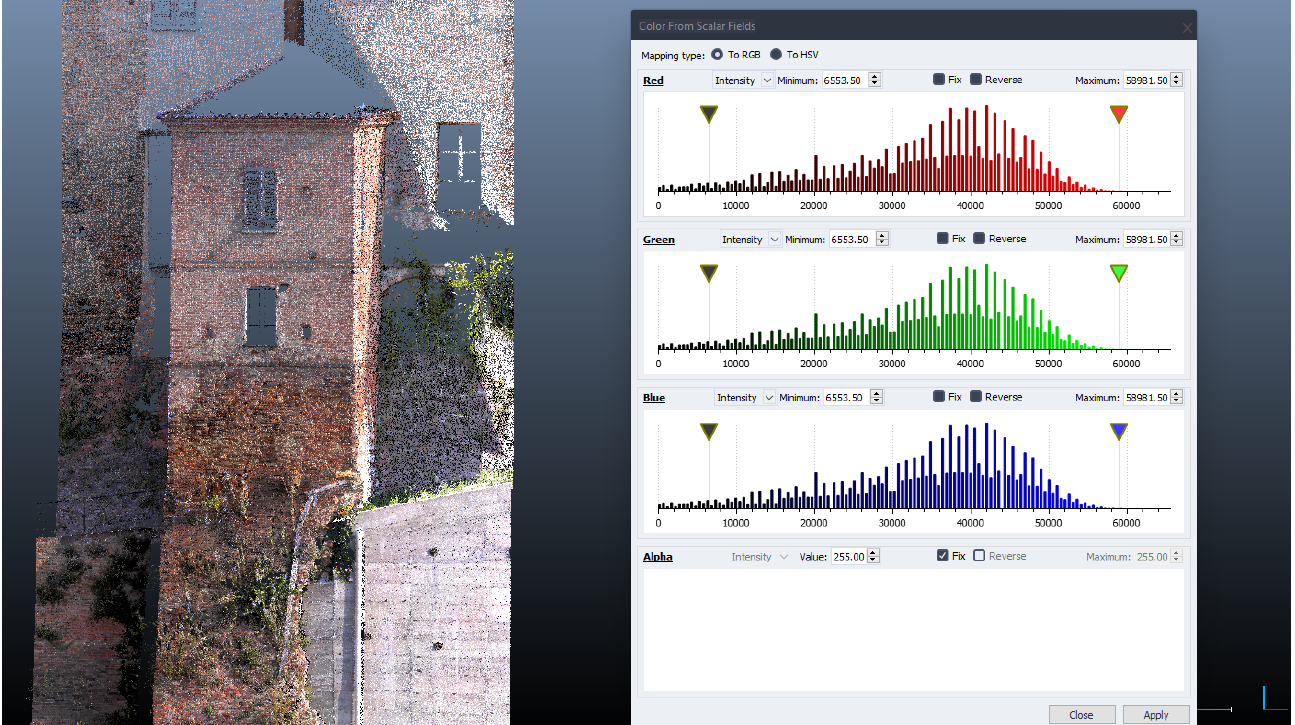
Figure 31. Radiometric values and red, green, and blue spectrums related to the TLS point clouds of the entrance tower.